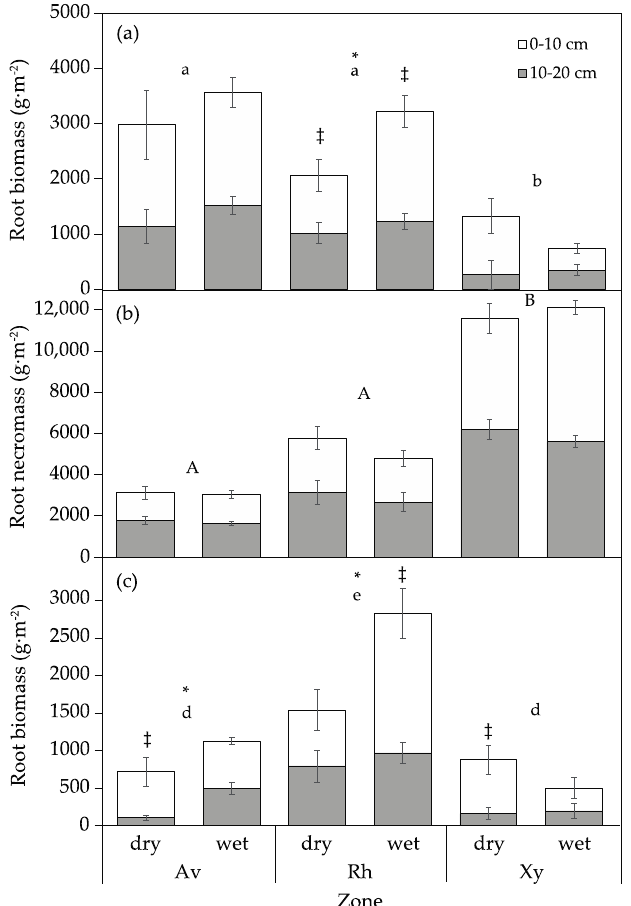
Figure 3. Total root biomass ( a ), necromass ( b ), and fine-root biomass ( c ) represented as the mean ± SE in the Avicennia (Av), Rhizophora (Rh), and Xylocarpus (Xy) zones during the dry and wet seasons in the separated soil depths. The symbols indicate significant differences from the independent t -test ( p < 0.05) between seasons (*) and soil depth (‡). The le tt ers show signi fi cant di ff erences among zones ( p < 0.05) using Tukey’s post hoc test and pairwise comparisons.